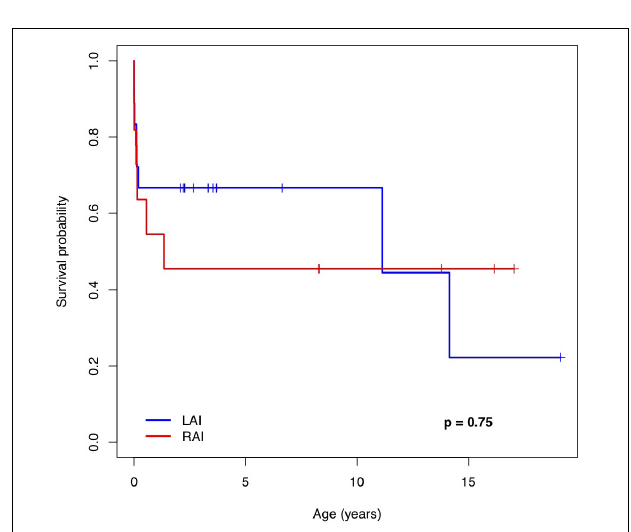
did not require cardiac surgery and are alive and well. Eight